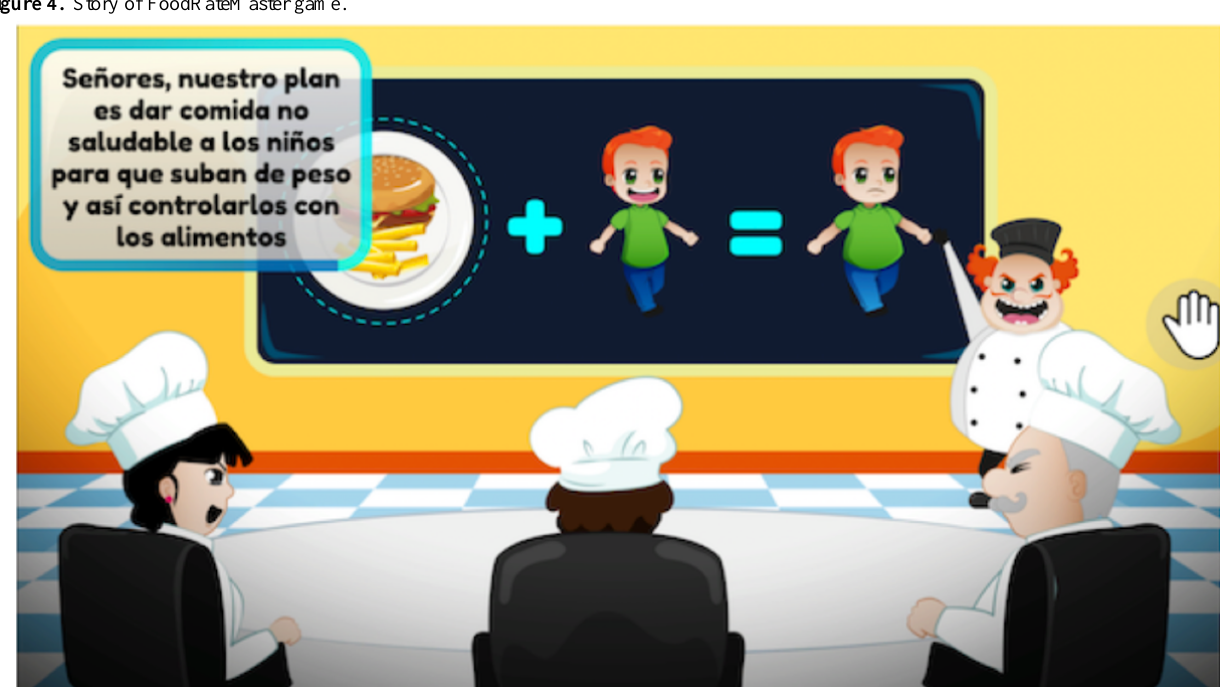
Figure 4. Story of FoodRateMaster